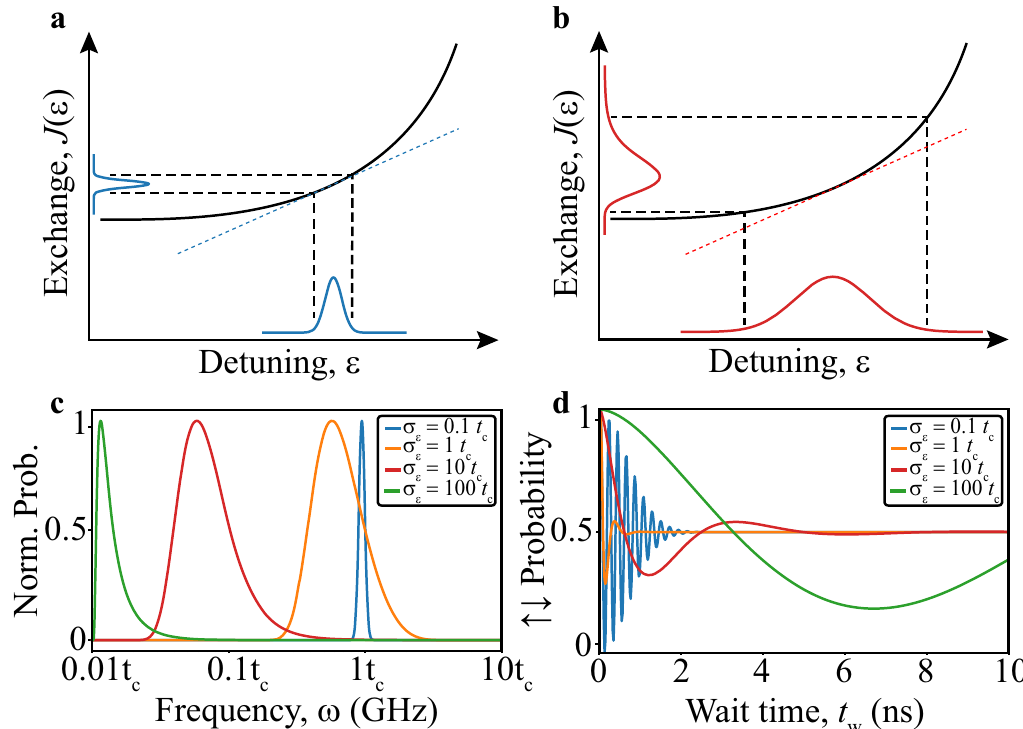
Fig. 2 Impact of charge noise on exchange oscillations. The probability density functions (PDFs) of the exchange-interaction strength J as a result of coupling to a low-magnitude (blue) and b high-magnitude (red) charge noise that causes a Gaussian distribution in detuning values ϵ . For low charge-noise magnitudes a the variation in J is well explained by the gradient (d J /d ϵ , blue dotted line) causing a proportional Gaussian distribution in J . For high charge-noise magnitudes b the variation in J deviates from the linear approximation (d J /d ϵ , red dotted line). This deviation causes a skewed-Gaussian distribution in J ( ϵ ) as the J ( ϵ ) values of less than average ϵ values are brought closer to the mean while the J ( ϵ ) values of above average ϵ values are taken further away from the mean. c Normalised PDFs of the frequency components F (coloured lines) for various magnitudes of charge noise characterised by σ ϵ relative to the tunnel coupling t c = 4.3 GHz when Δ E Z = 117.53 MHz. The intended detuning is chosen to be μ ϵ = 0 as an example. d Fourier transforms of the corresponding PDFs in c depicting the relevant exchange oscillations as a function of the wait time t w for given charge-noise values. For these examples, the Hubbard model has been used for the exchange-strength dependence on